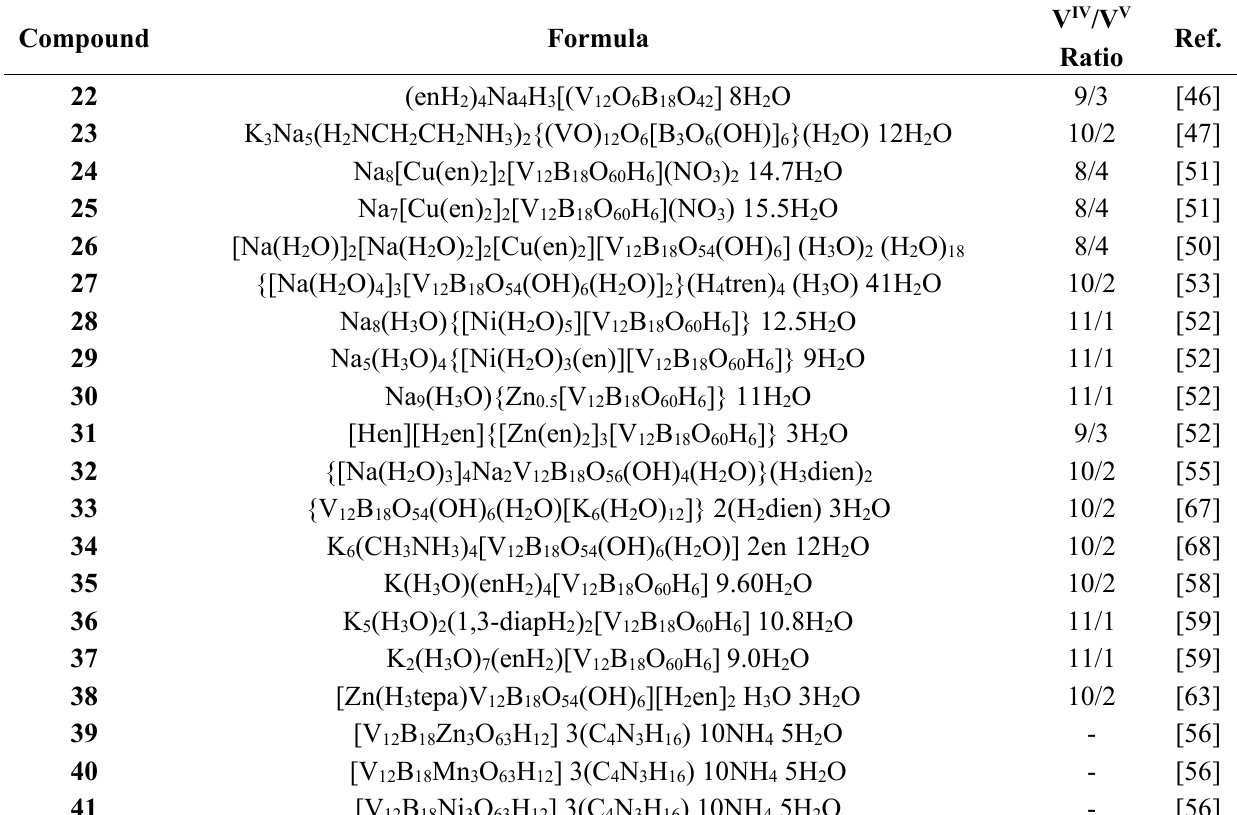
Table 4. List of the lattices with organic ammonium, alkaline, and/or transition metal ions as counterbalancing cations. The mixed valence V IV /V V ratio is indicated for each lattice.